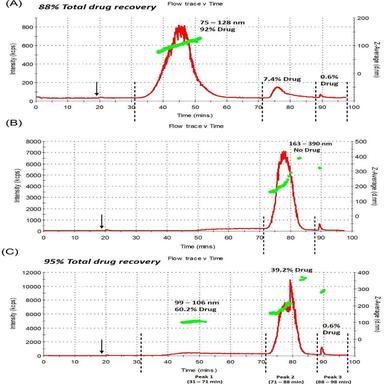
Flow-mode diameter (AF4 separation with in-line DLS) for A) 'bilayer-loaded drug liposomes'. B) Multi-lamellar vesicles (MLV). C) 'Bilayer-loaded drug liposomes' incubated with MLV. The hydrodynamic size was measured across the peaks (green squares) using the on-line Malvern Zetasizer and was based on an intensity threshold of >500 (A), >500 (B), and >400 (C) kcps. The size ranges are given in the figure for each peak. Collected peak fractions are designated by dashed vertical lines along with the elution t